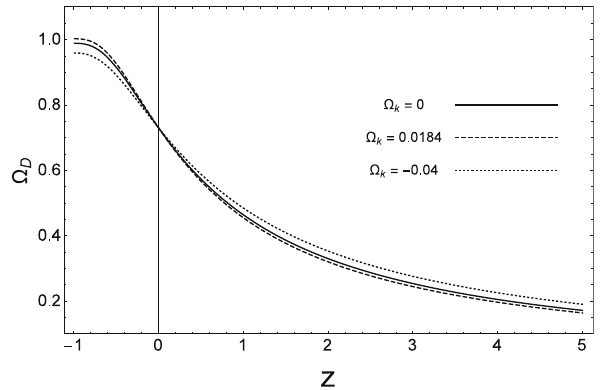
Fig. 14 The evolution of the THDE density parameter (cid:5) D , as a func- = 0 . 73, b 2 = 0 . 011, b 2 = 0 . 01 and δ = 1 . 4. The tion of z , for (cid:5) 0 D 1 2 values of curvature density parameter has been extracted from the data provided in [113]